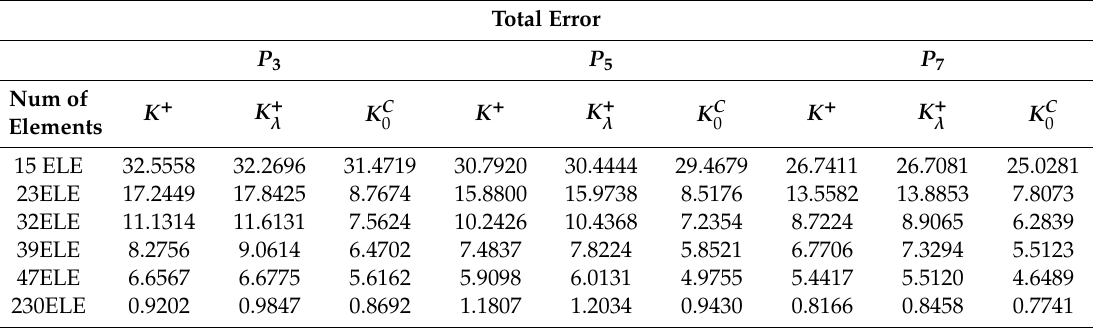
Table 7. Errors of the entire domain for various angular